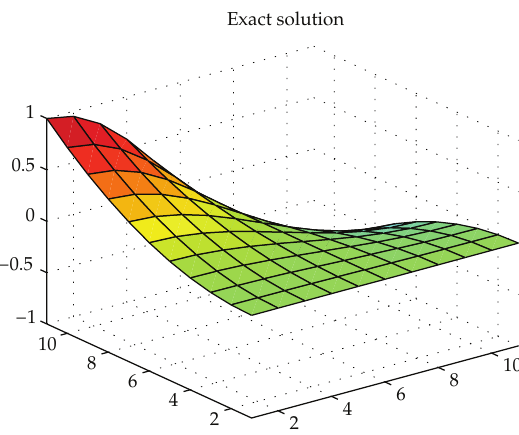
Figure 1: The surface shows the exact solution u (cid:3) t,x (cid:4) for (cid:3) 2.9 (cid:4) .